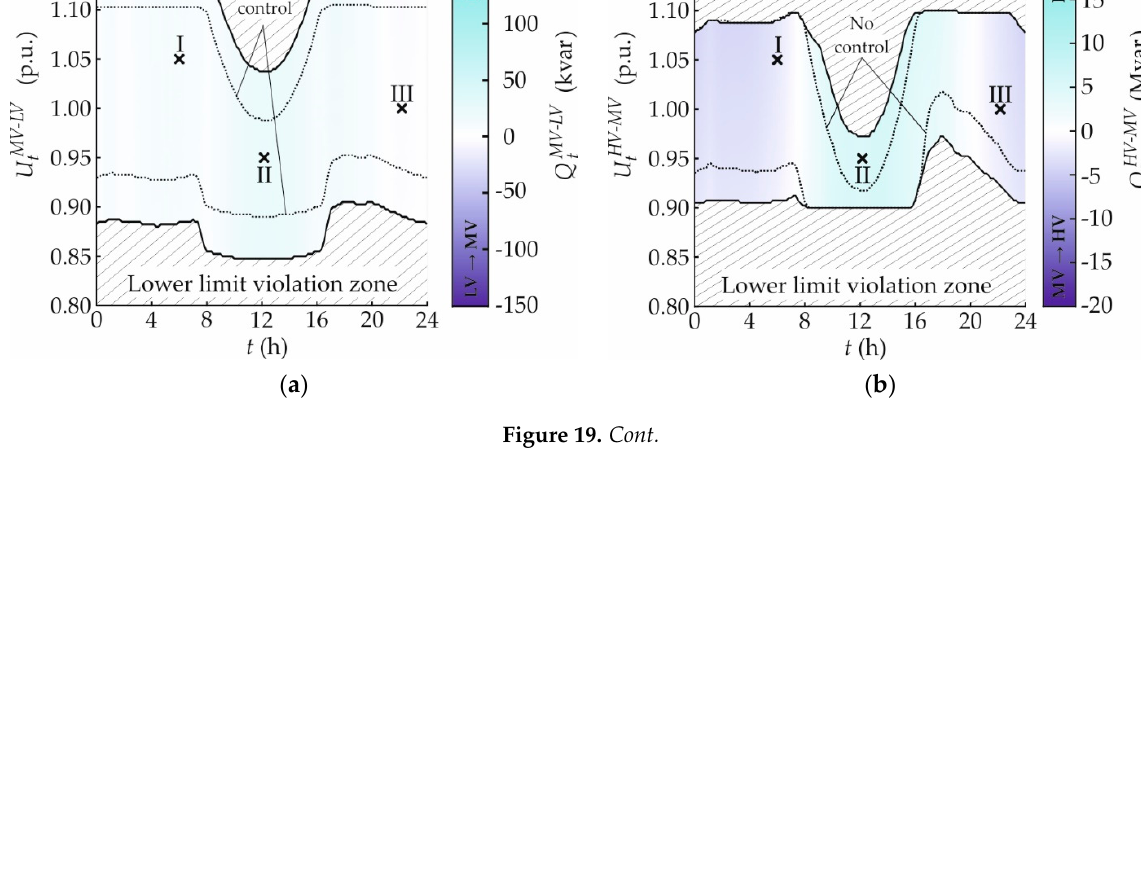
Figure 18. Daily behavior of the test link chain for various boundary voltages and the X ( U ) local control: ( a ) reactive power exchange over the MV − LV boundary (rural LV_Link-Grid); ( b ) reactive power exchange over the HV − MV boundary; ( c ) active power loss within the rural LV_Link-Grid; ( d ) active power loss within the MV_Link-Grid; ( e ) DTR loading (rural LV_Link-Grid).